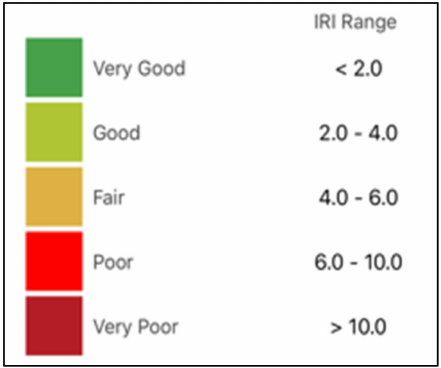
Figure 5. Color coding for road roughness [16].